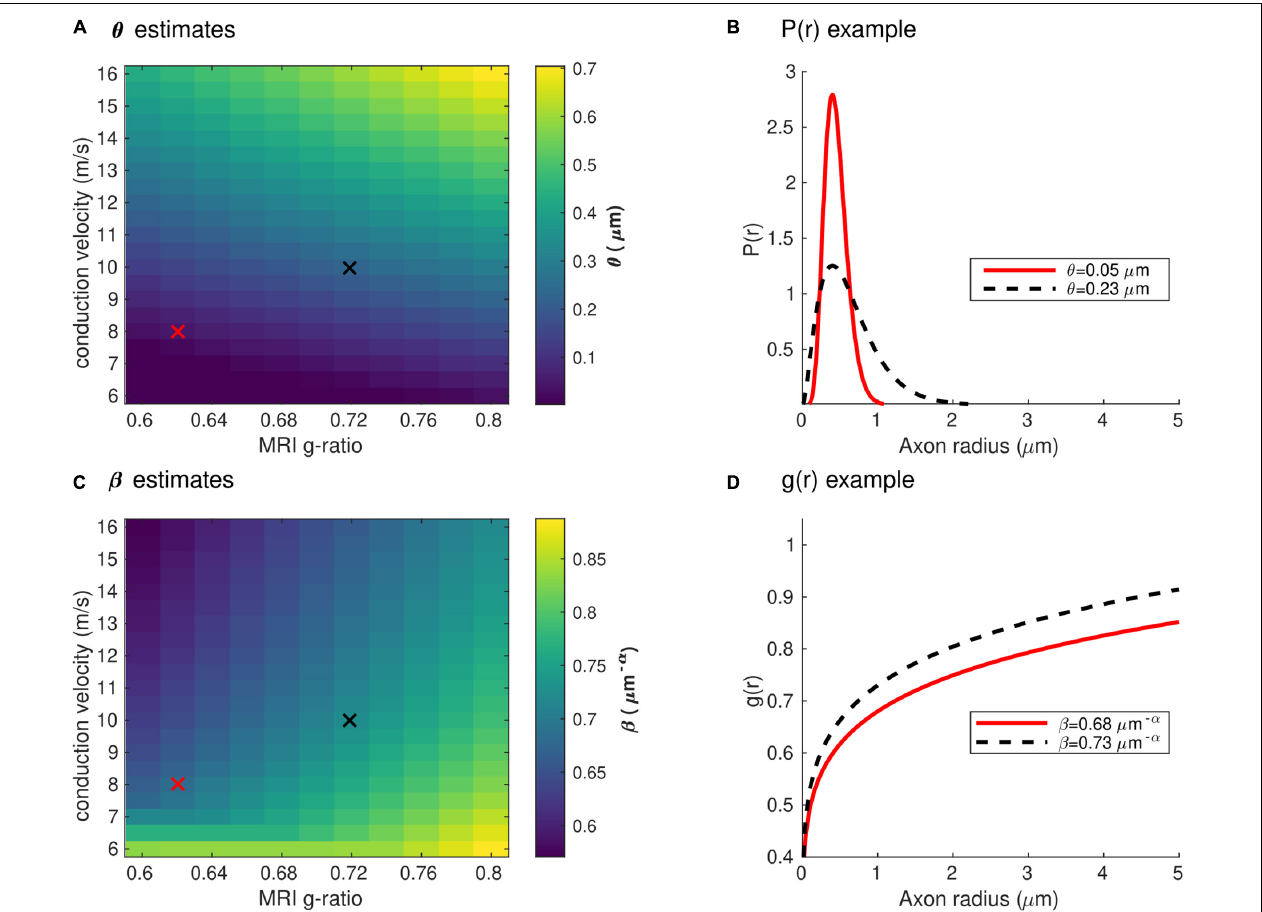
FIGURE 4 | Range of the model parameters θ and β . (A) Range of the model parameter θ , computed from combinations of simulated in vivo g MRI and V . (B) Axonal radius distributions representative of frontal and visual transcallosal white matter ( θ = 0.05 and 0.23 µ m). (C) Range of the model parameter β , computed from combinations of simulated in vivo g MRI and V . (D) Dependence of the fiber g-ratio on the axonal radius, representative of frontal and visual transcallosal white matter ( β = 0.68 and 0.73 µ m − α ). In (A,C) , the red and black crosses illustrate values of g MRI and V for frontal and visual transcallosal tracts, taken from the literature (Caminiti et al., 2013; Mohammadi et al., 2015; Slater et al.,